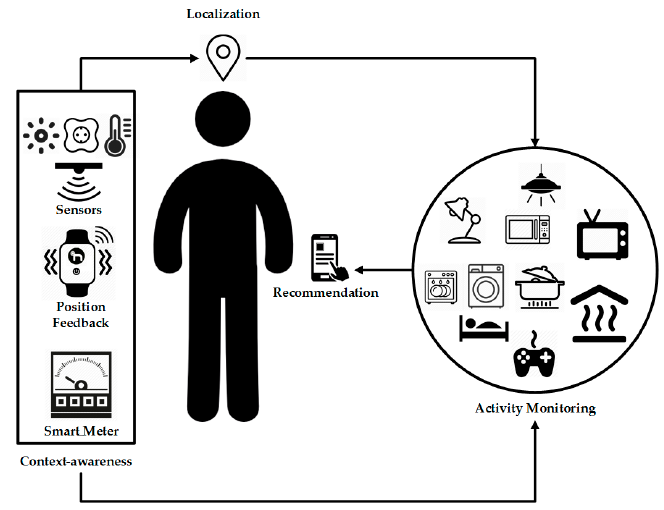
Figure 1. The presented model collects contextual information and users’ location. These data, merged with user activity monitoring, allow generating recommendations that foster energy